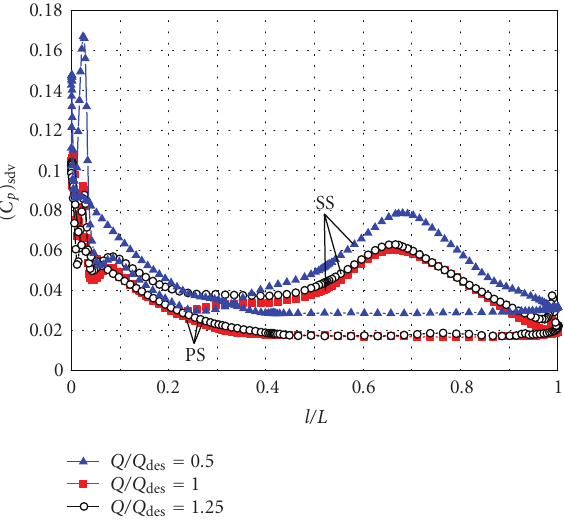
Figure 9: Comparison of pressure fluctuation on the di ff user vane,